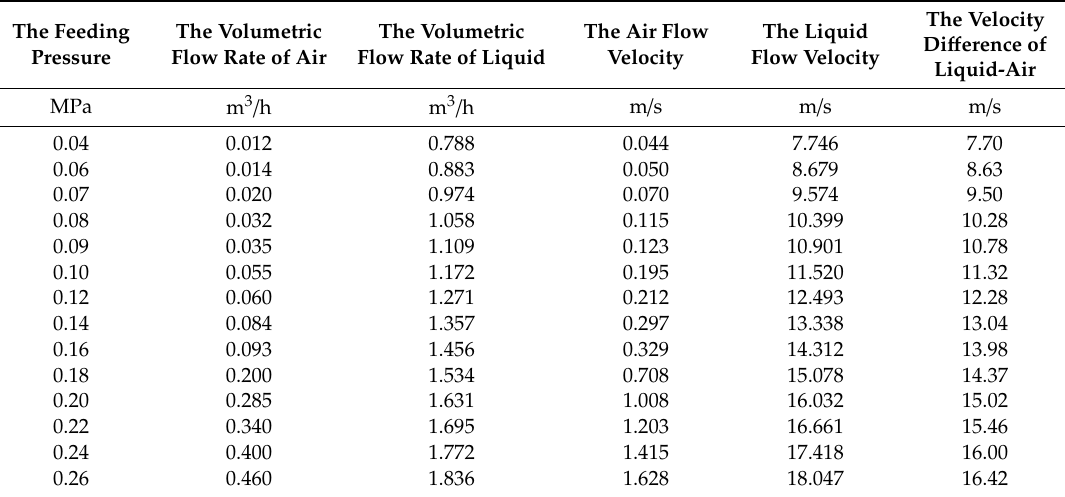
Figure 6. Suction capacity ( q ) as a function of negative pressure ( p ). Table 3. The velocity difference of liquid-air.